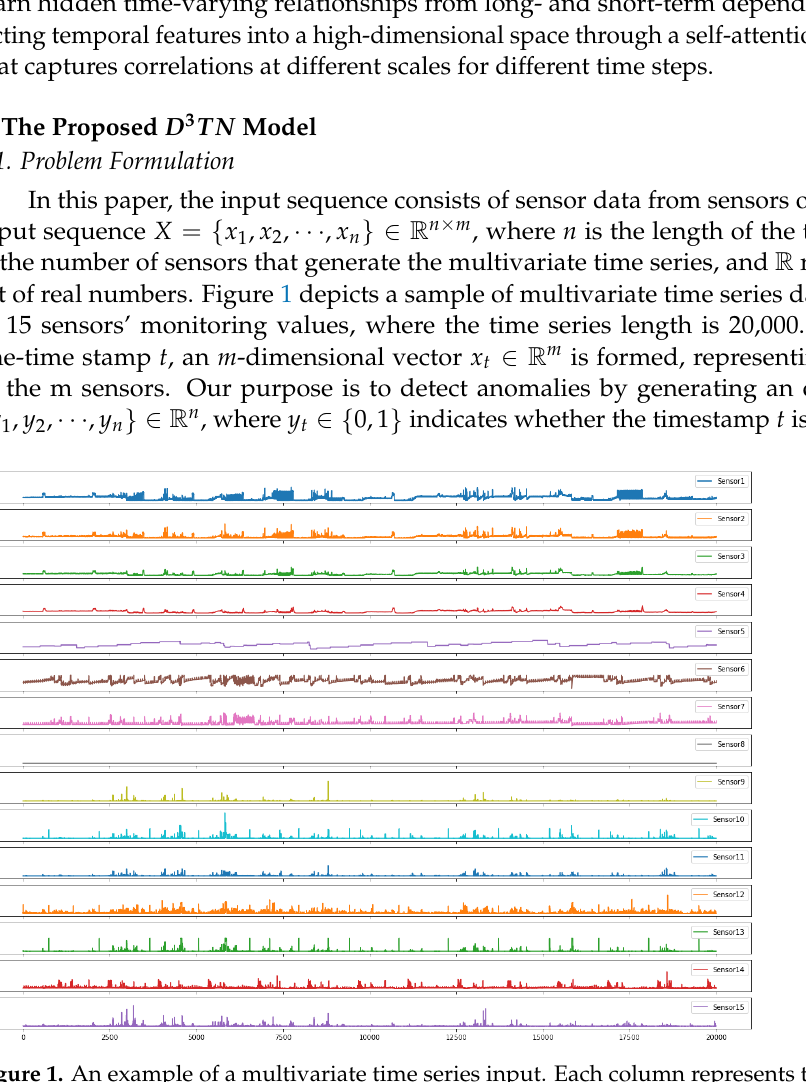
Figure 1. An example of a multivariate time series input. Each column represents the value of the multivariate time series at timestamps, while each row represents a sensor detection